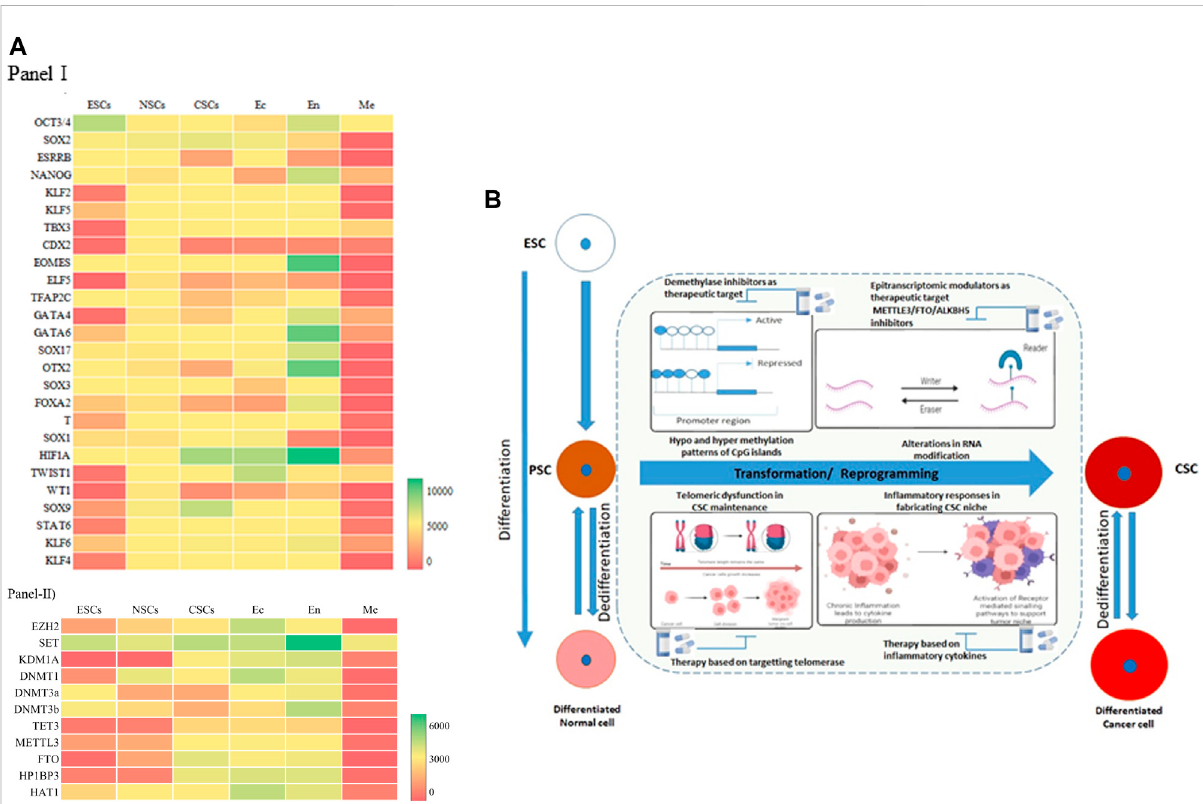
FIGURE 2 Resetting the Epigenome Dynamics in Differentiation and Dedifferentiation. (A) Heat map of Panel I, Transcription Factors (26) expression and Panel II modi fi ers (11) such as Histone methyltransferase/demethylase, DNMT/demethylase, RNA methyltransferase/demethylase in different cell types-embryonicstemcells(ESCs),neuralstemcells(NSCs),cancerstemcells(CSCs),ectoderm(Ec),endoderm(En),mesoderm(Me).Theredcolor indicates a lower expression level, and the green indicates a high expression level. Yellow represents intermediary expression levels. The intensity of the color indicates the expression level. Gene Expression Omnibus (GEO) database (https://www.ncbi.nlm.nih.gov/geo/) was used to gather the data for the six types of cells/tissues EMBRYONIC STEM CELLS (Datasets- GSE220881 and GSE775182), NEURAL STEM CELLS (Datasets- GSE380453 and GSE353904), CANCER STEM CELLS (Datasets- GSE433785 and GSE42906), ECTODERM (Datasets- GSE339037 and GSE1442418), ENDODERM (Datasets- GSE1080479, GSE5528310, and GSE2413511), MESODERM (Datasets- GSE18216112 and GSE11477613). Excel software was used to plot the heatmap. The selected data is converted into the heat map using conditional formatting (color scales). (B) A combination of